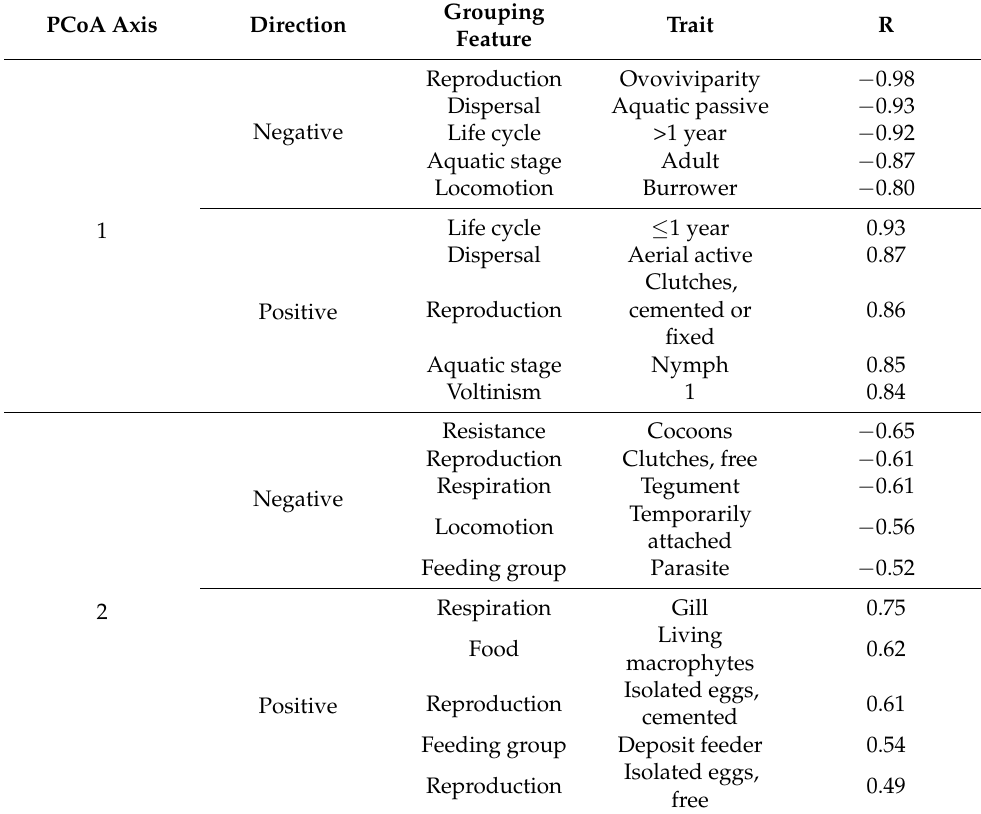
Table 2. Five strongest positive and negative Pearson correlation values between PCoA axes 1 and 2 versus individual functional